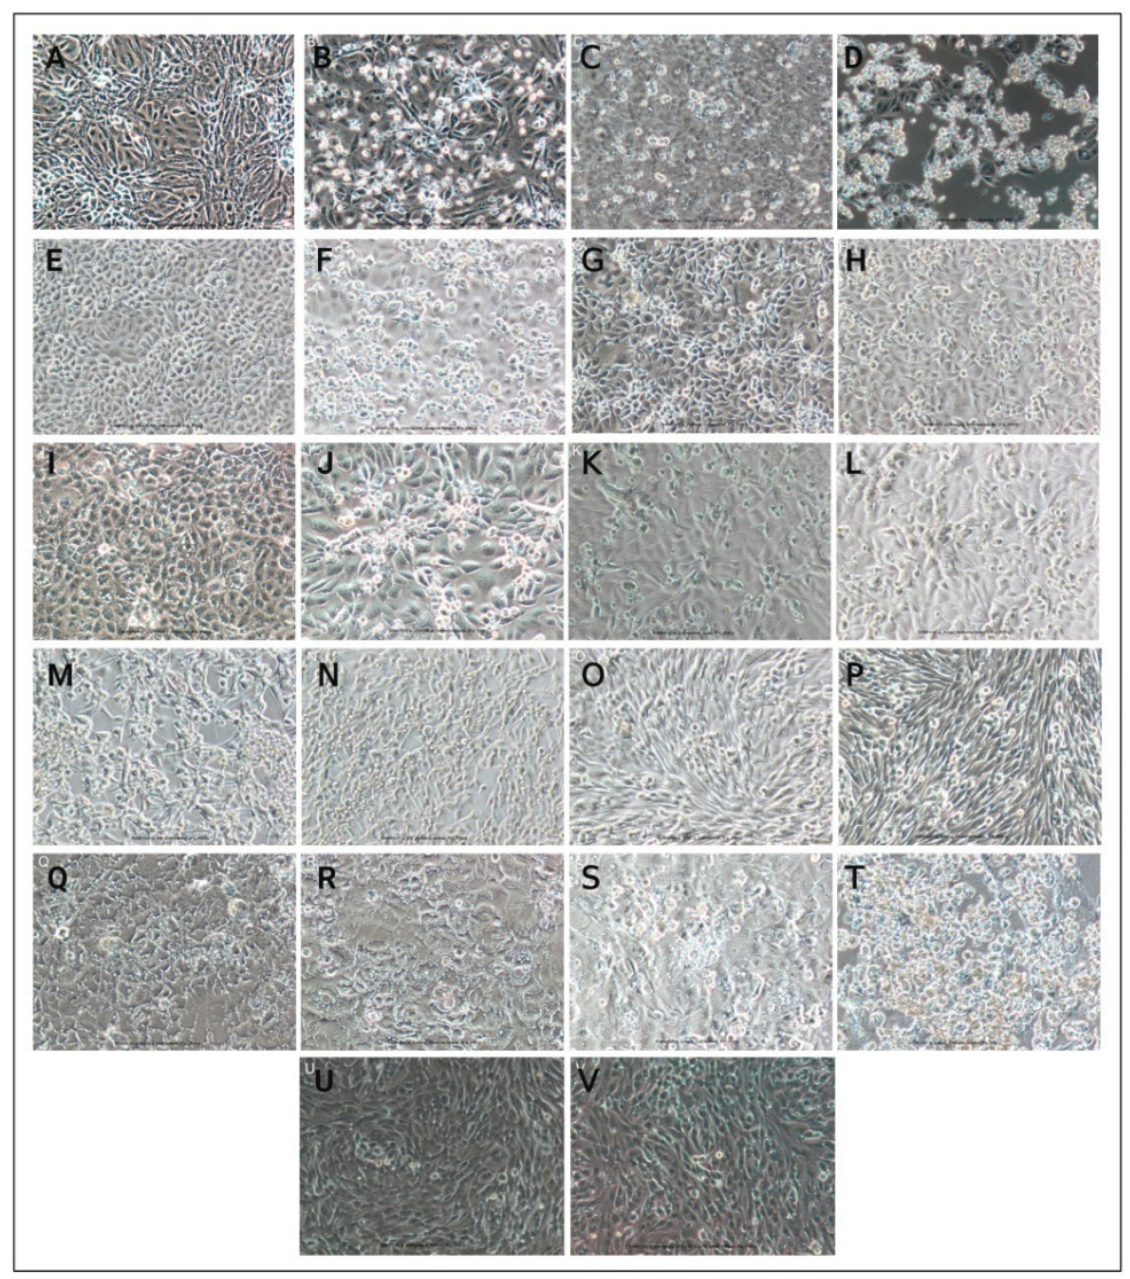
Figure 1. Cell lines were inoculated with the SARS-CoV-2 Omicron (BA.1.1) variant, and uninfected cells were used as a cell control for each cell line. Microscopy images (original magnification × 10) captured on 5 days post-infection. The cytopathic effect of omicron BA.1.1 variant in different cell lines. ( A ) Uninfected Vero CCL-81 cells; ( B ) Infected Vero CCL-81 cells; ( C ) Uninfected Vero E6 cells; ( D ) Infected Vero E6 cells; ( E ) Uninfected Vero hSLAM cells; ( F ) Infected Vero/hSLAM cells; ( G ) Uninfected MA-104 cells; ( H ) Infected MA-104 cells; ( I ) Uninfected LLC MK-2 cells PID5 P-2 ( J ) Infected LLC MK-2 cells; ( K ) Uninfected A549 cells; ( L ) Infected A549 cells; ( M ) Uninfected RD cells; ( N ) Infected RD cells; ( O ) Uninfected MRC-5 cells; ( P ) Infected MRC-5 cells; ( Q ) Uninfected Caco-2 cells; ( R ) Infected Caco-2 cells; ( S ) Uninfected Calu-3 cells; ( T ) Infected Calu-3 cells; ( U ) Uninfected BHK-21 cells; ( V ) Infected BHK-21 cells. Table 2. Differential cell line susceptibility to Omicron BA.1.1 variant as defined by cytopathic effect (CPE) on days 1 to 5 after infection with SARS-CoV-2 Omicron BA.1.1. Sr. No. Cell Line